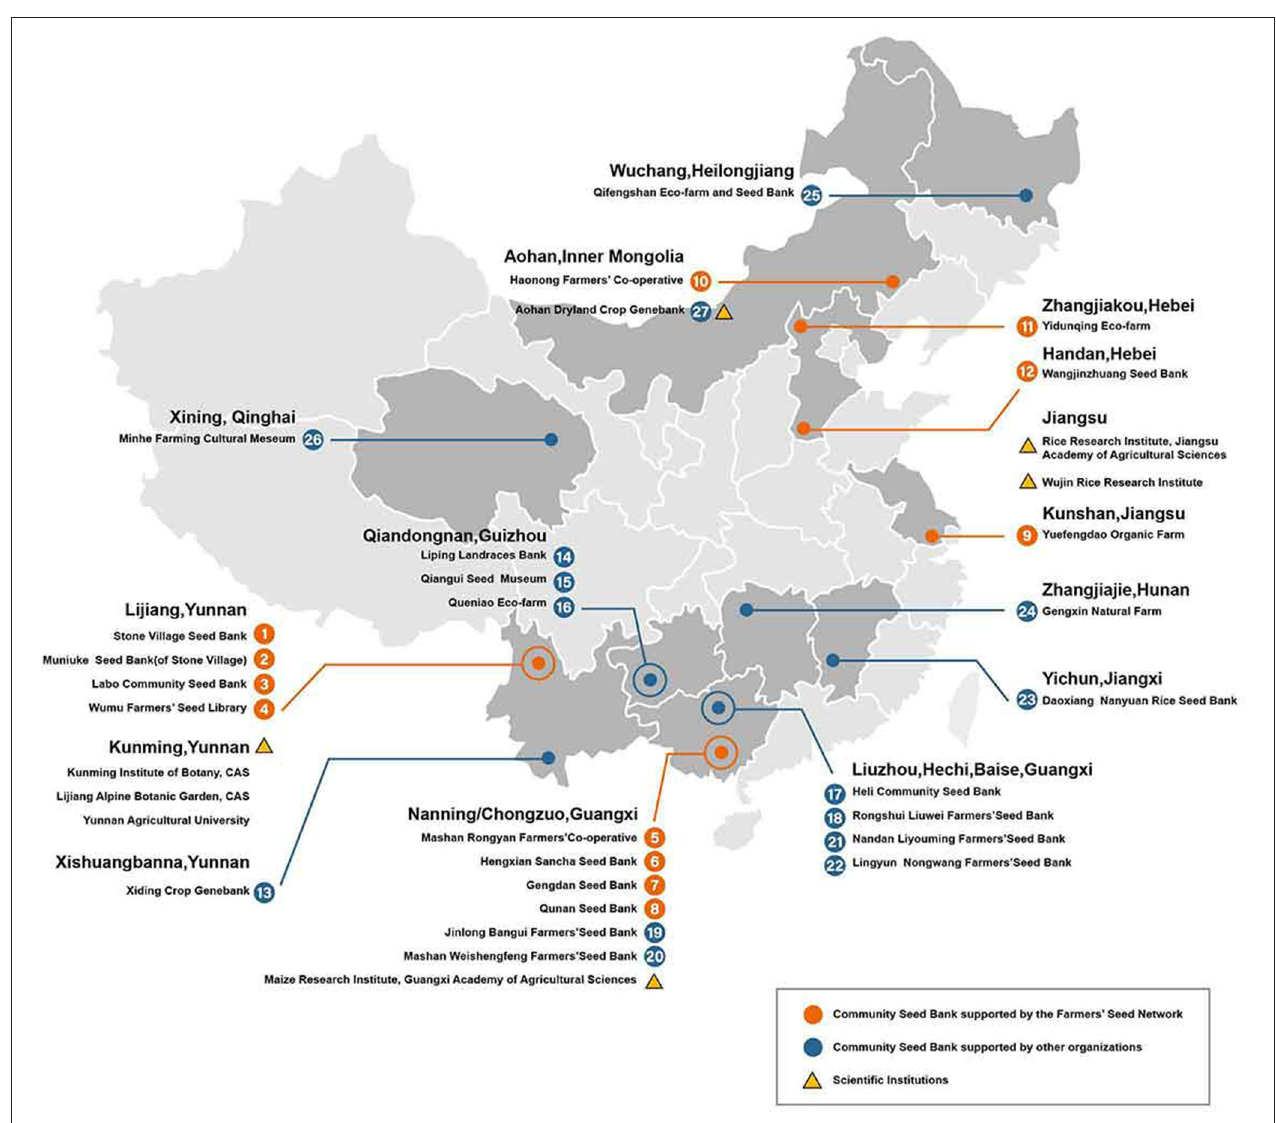
FIGURE 1 | Geographic distribution of community seed banks in China